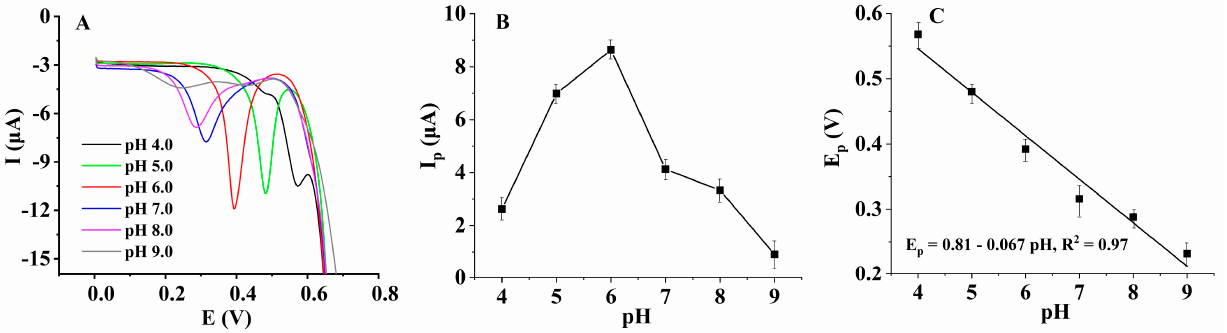
Figure 7. ( A ) Differential pulse voltammograms of 200 µ M HcySH on AuNPs/AB–DHP/GCE in 0.15 M PBS with different pH values. ( B ) Linear relationship between the oxidation peak current of HcySH and the pH value. ( C ) Linear relationship between the oxidation peak potential of HcySH and the pH value.